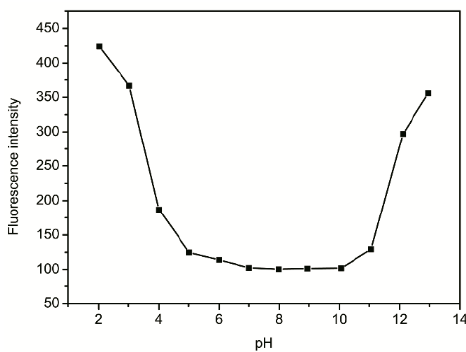
Figure 5. The effect of different pH values on the spectroscopic characteristics of Cu 2+ - ACP .